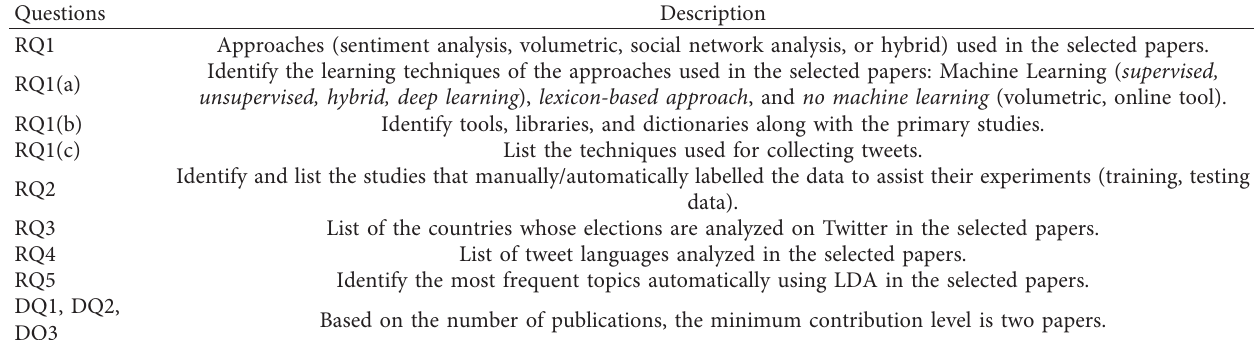
Table 1: Description of research and demographic questions (RQs and